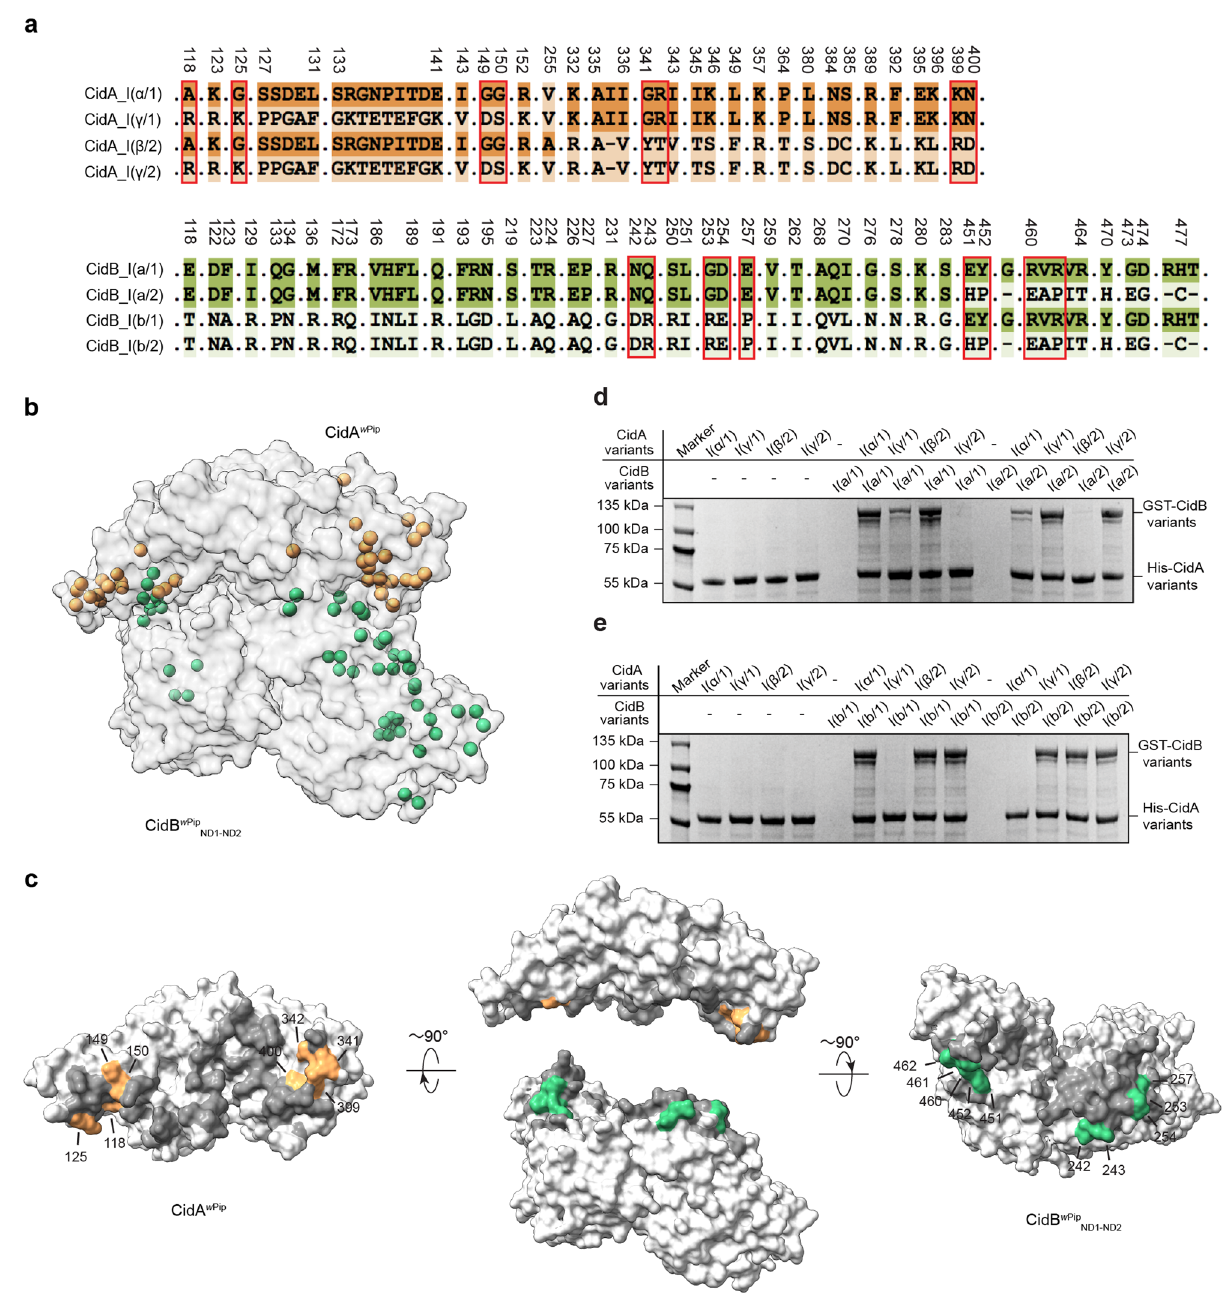
Fig. 4 Sequence variations modulate interactions between natural CidA w Pip and CidB w Pip alleles. a Sequence alignment shows that residues at certain positions are different among the CidA w Pip and CidB w Pip variants. The residues that are the same among the variants are not shown. The varied residues which are located at the binding interfaces are boxed. The numbers above sequence alignment were based on the sequences of CidA and CidB from w Pip Tunis. b The locations of the varied residues are shown as spheres on the structure of the CidA w Pip(Tunis) -CidB w Pip(Tunis) ND1-ND2 complex. c The varied residues which are located at the binding interfaces are colored and labeled. Other residues at the binding interfaces are shown in gray. d , e His-tagged CidA variants were used to pull down GST-tagged CidB variants. The proteins were detected by Coomassie Blue staining. These experiments were repeated three times independently with similar results obtained. One representative is shown. ND nuclease domain. Source data for panels ( d ) and ( e ) are provided as a Source Data fi